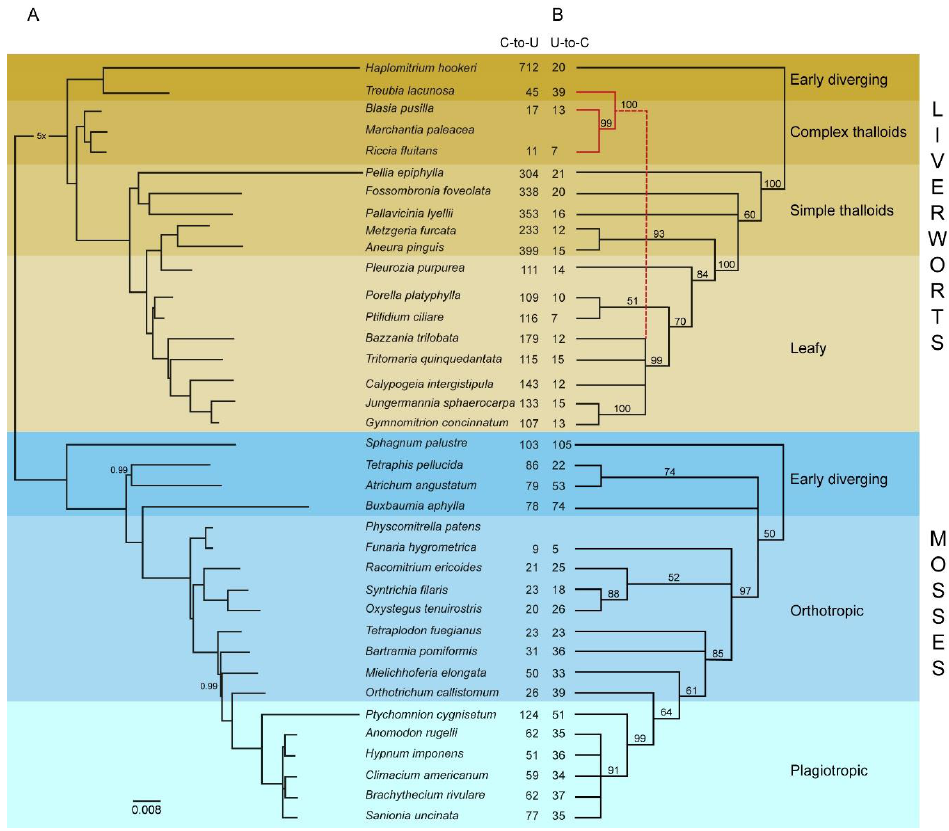
Figure 1. Phylogenetic relationships of 37 species of liverworts and mosses based on 33 concatenated mitochondrial protein-coding sequences and predicted RNA editing sites. ( A ) Phylogenetic tree obtained as a result of Bayesian inference analysis of 33 concatenated protein-coding sequences of 37 species. All branches are maximally supported unless otherwise marked. The scale bar indicates the number of substitutions per nucleotide position. ( B ) Phylogenetic tree obtained as a result of maximum parsimony analysis of binary matrix of predicted C-to-U RNA editing site occurrence within the 33 aforementioned protein-coding sequences of 35 species. The support values are given at the nodes. Two columns in the middle of the graph depict the total number of C-to-U and U-to-C editing sites predicted within the aforementioned species